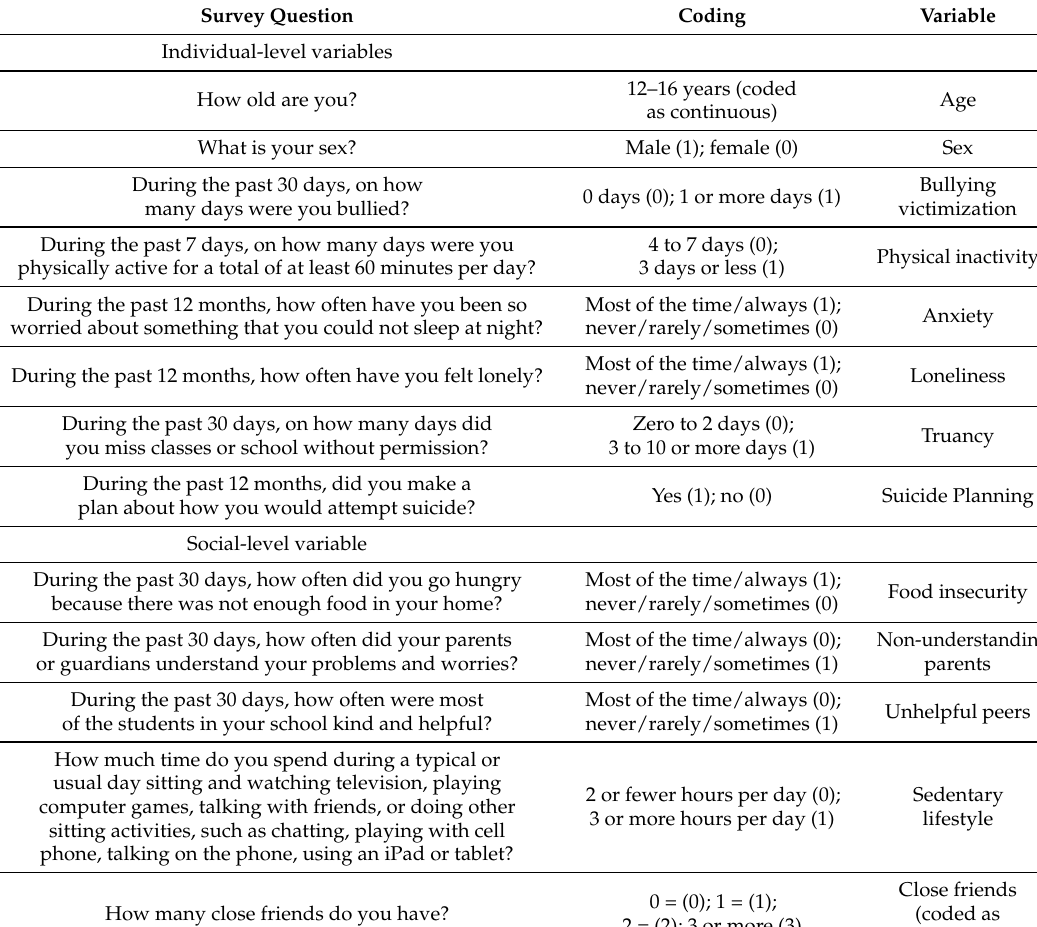
Table 1. Independent variable derivation from Global School-based Health Survey (GSHS) survey data from El Salvador,